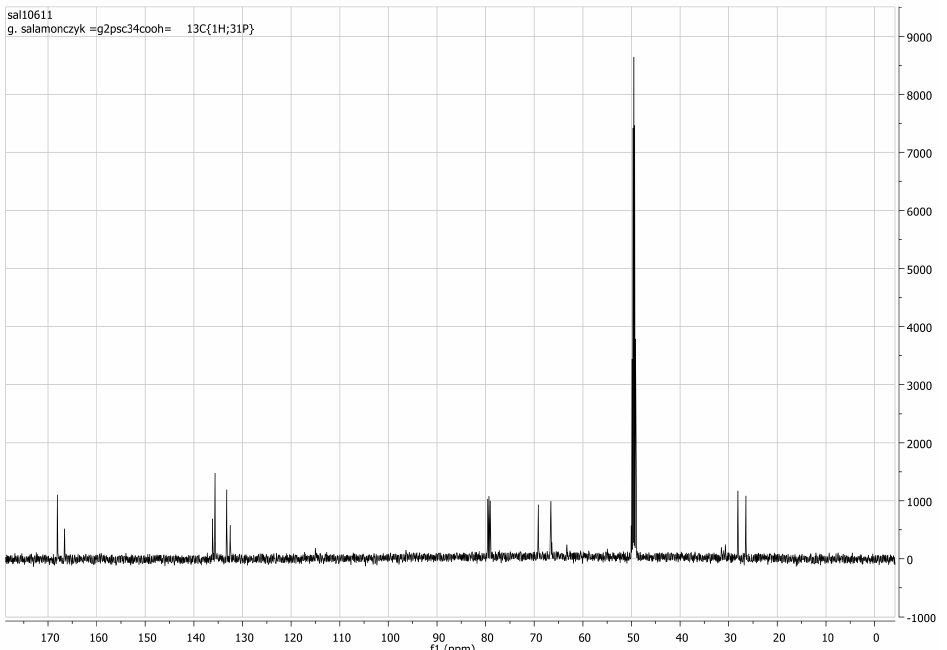
Figure 2. 13 C NMR spectrum of polyanionic dendrimer